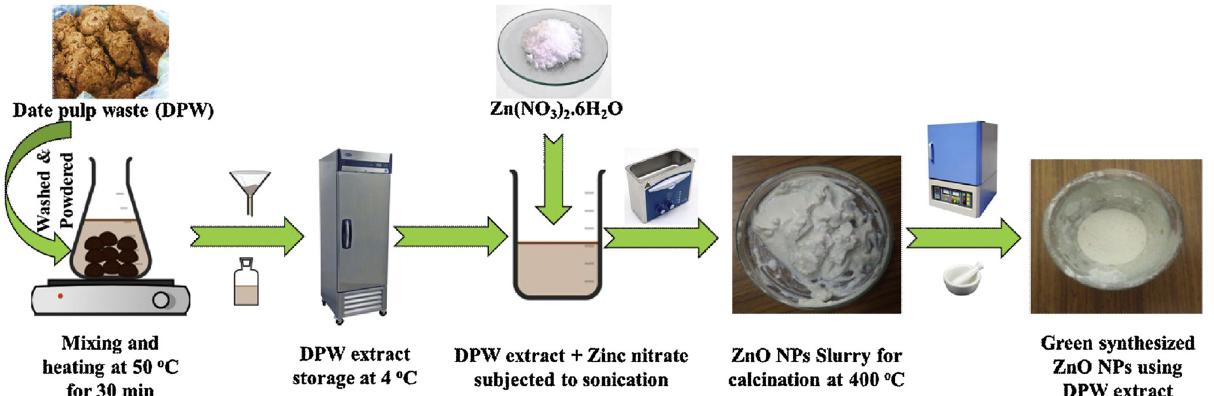
Figure 23: Synthesis steps of ZnO NPs. Copied with permission from ref. [ 275 ] ; Elsevier,